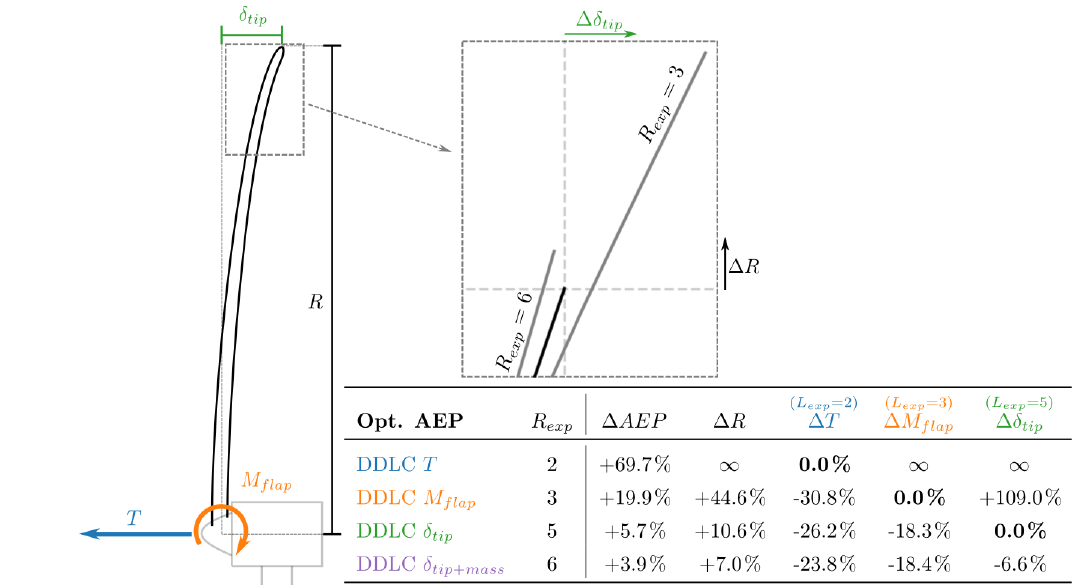
Figure 14. Sketch of a turbine with the load/structural response outlined. The zoomed-in figure shows the radius increase ( (cid:49)R ) and the change in tip deflection ( (cid:49)δ tip ) for two different DDLCs (bold black line is the baseline). The table shows the relative change in power, radius and load/structural response for different DDLCs. R exp = 2 is a thrust constraint design, R exp = 3 is a flap moment constraint design, R exp = 5 is a tip deflection constraint design and R exp = 6 is tip deflection+constant mass constraint